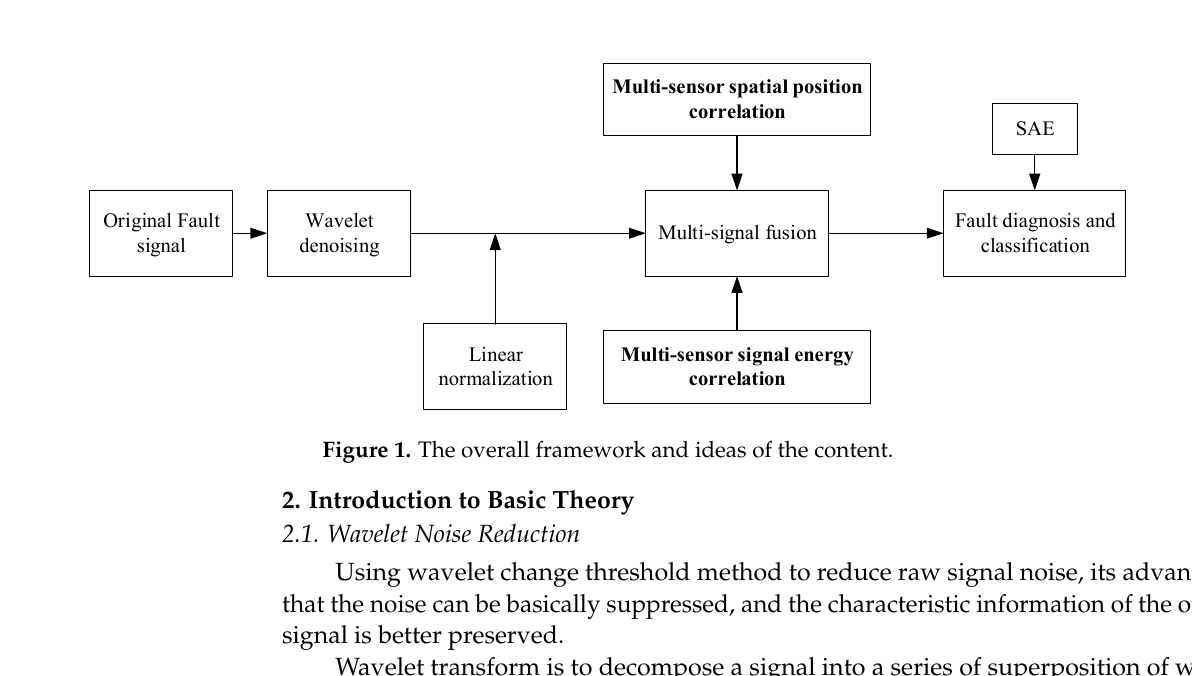
Figure 1. The overall framework and ideas of the content.